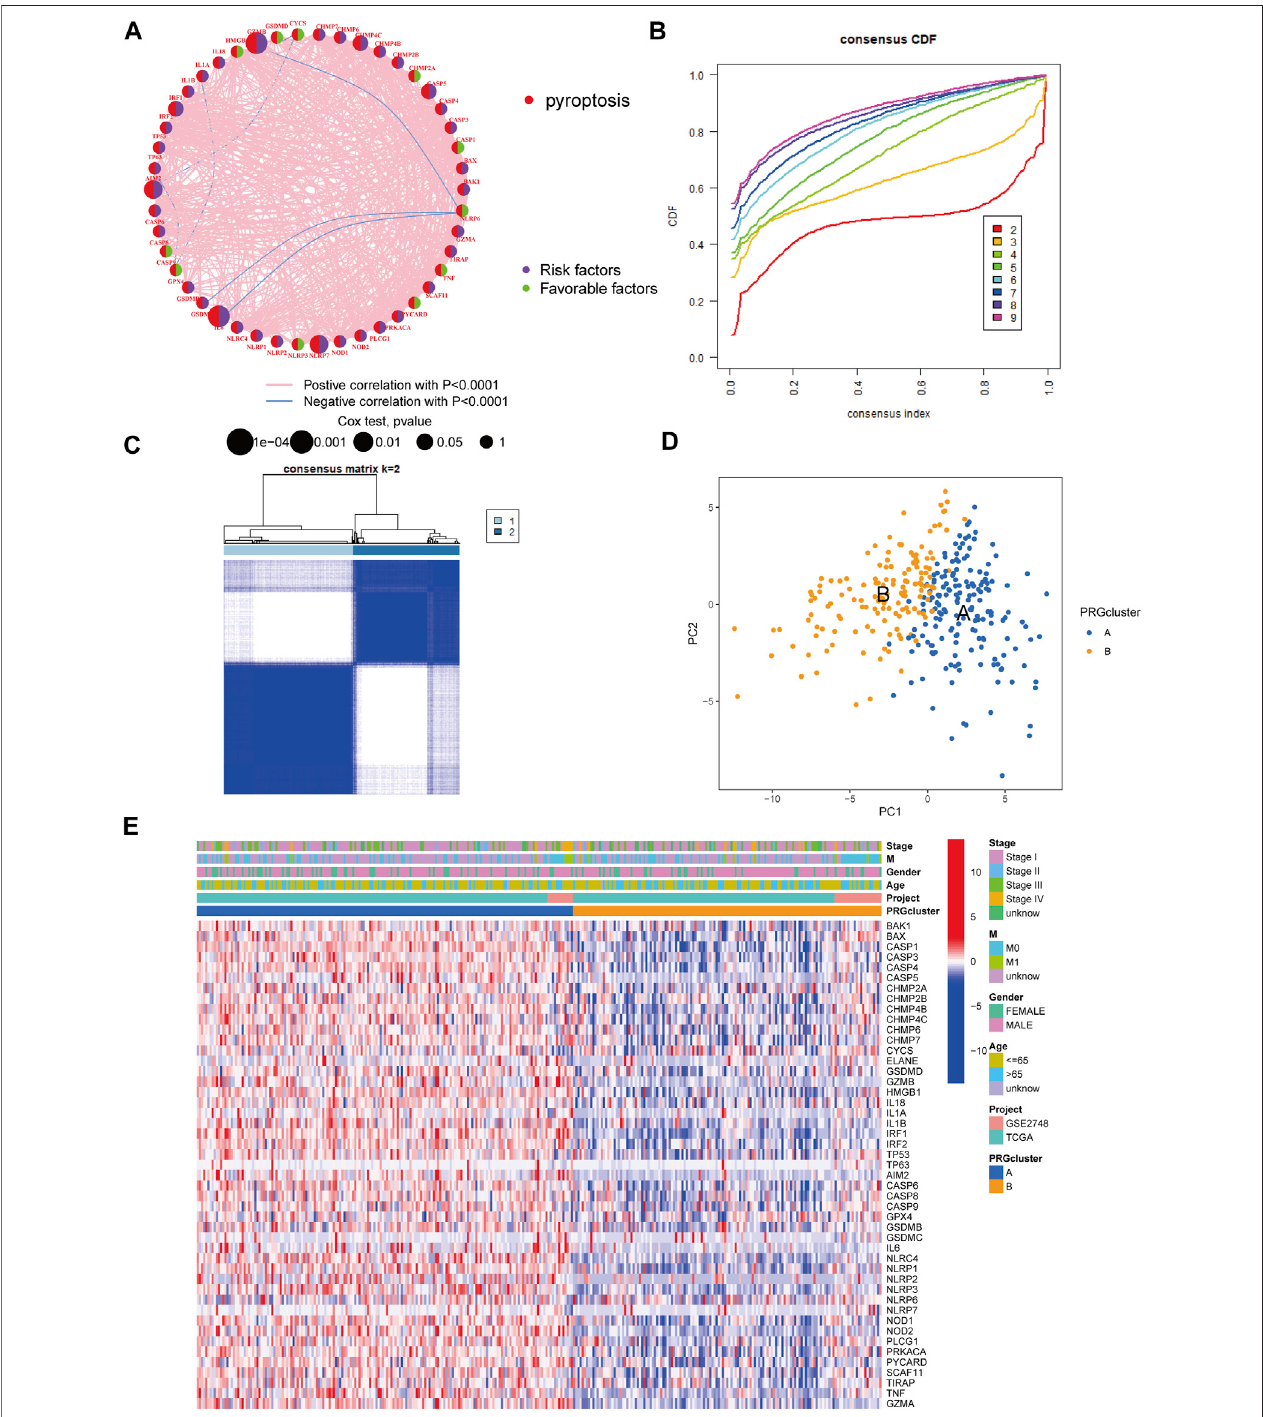
FIGURE 2 | Unsupervised cluster analysis divided KIRP patients into subclusters. (A) Interactions of PRGs in KIRP. (B) The cumulative distribution function (CDF) for consensus clustering. (C) Heatmap of the consensus matrix identifying two clusters and their correlation area. (D) Principal component analysis (PCA) between the two subtypes. (E) PRG heatmap in KIRP between two distinct